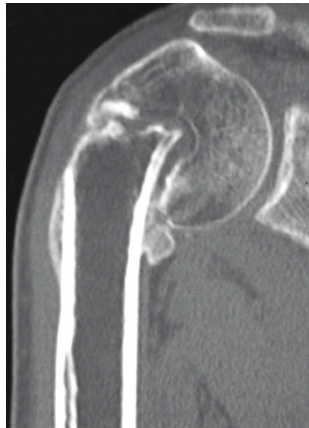
Figure 2: Preoperative CT image (oblique coronal plane) clearly shows that the greater tuberosity locates just beneath the undersur- face of acromion.